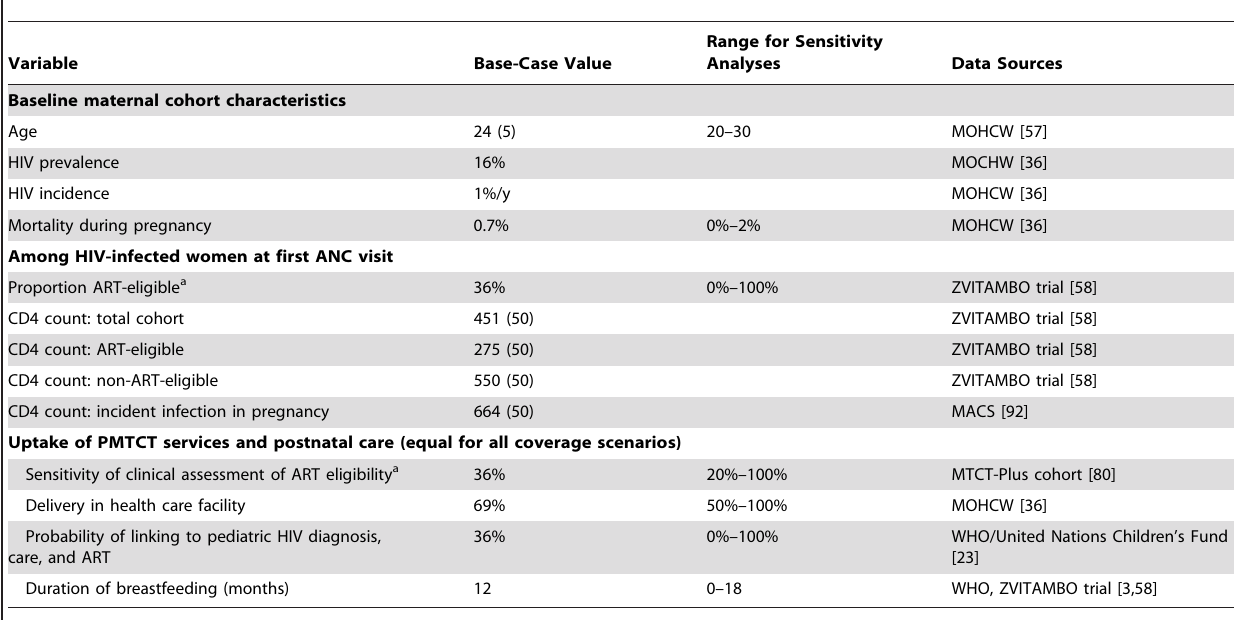
Table 2. Model input parameters: maternal characteristics and uptake of PMTCT